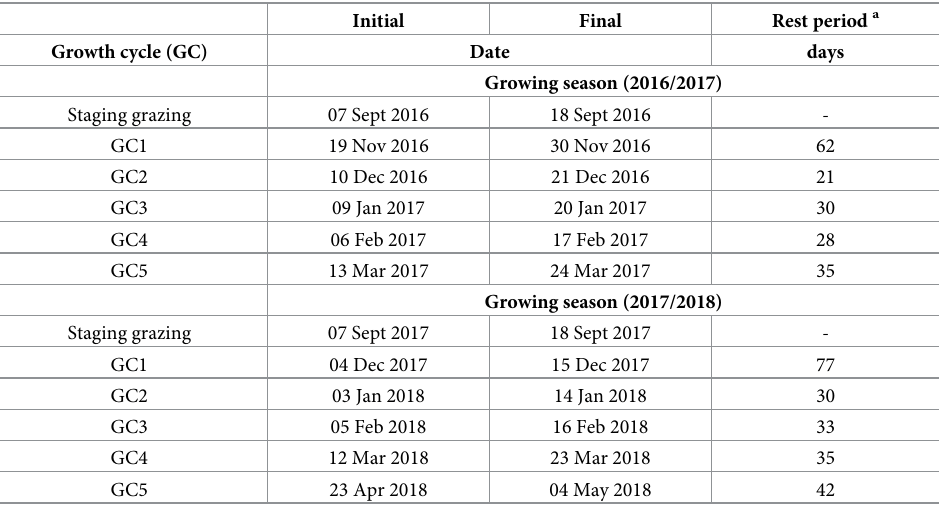
Table 1. Sequence of events over two production